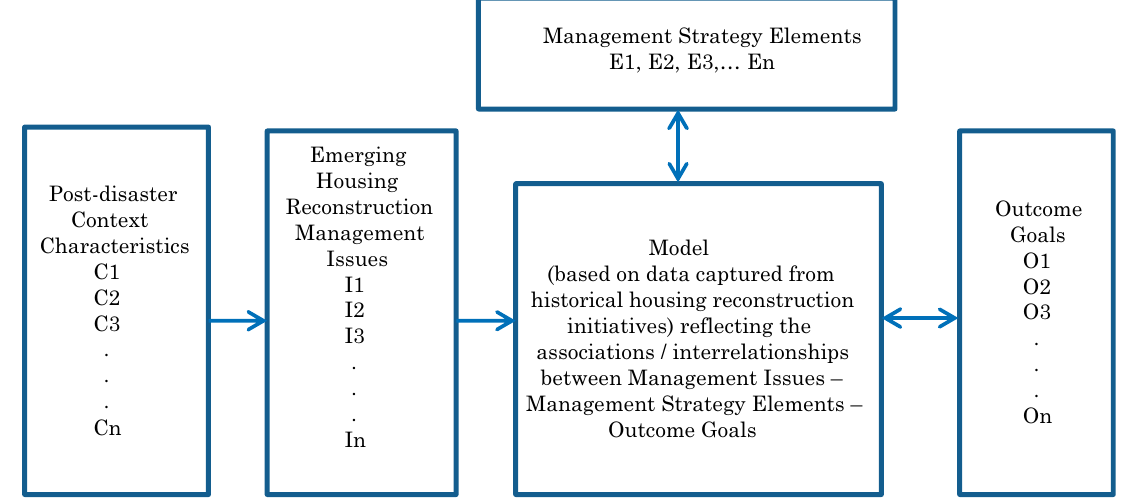
fig. 1. Conceptual framework for effective housing reconstruction management